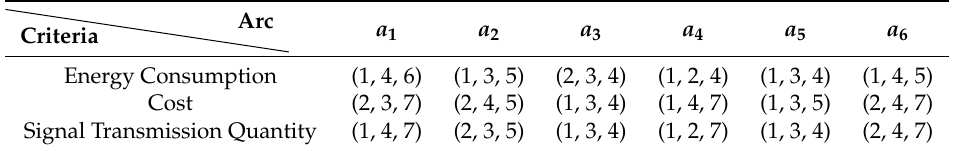
Figure 2. Example WSN. Table 1. The fuzzy energy consumption, fuzzy cost and fuzzy signal transmission quantity of sensors in Figure 2.